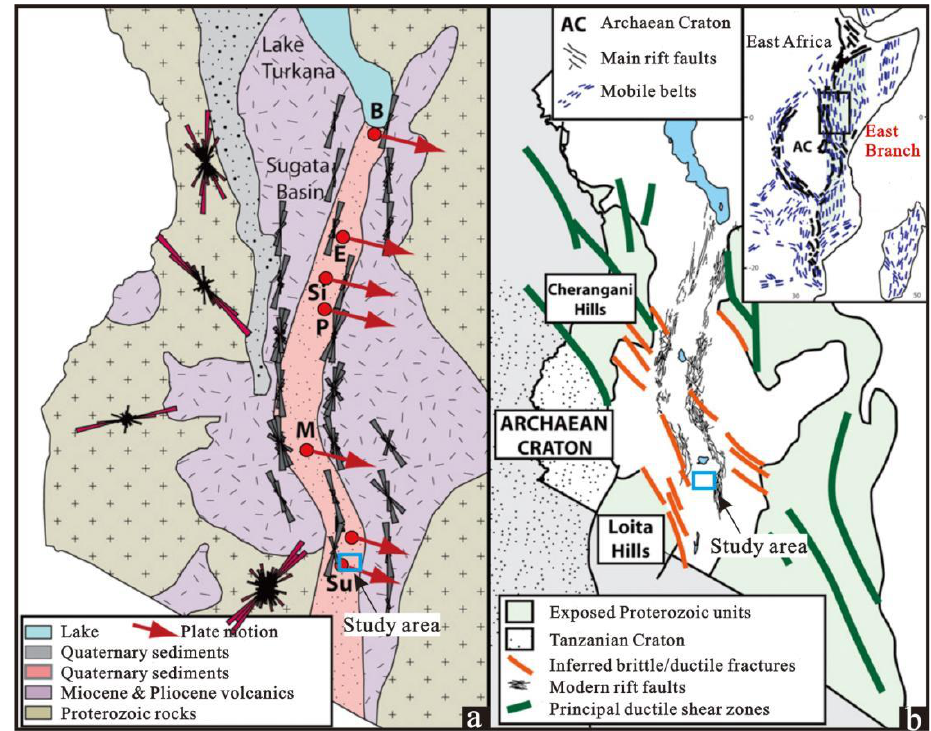
Figure 2. Geological structure of the Kenya Rift Valley, modified from Robertson et al. [13]. ( a ) Sum- mary geological map of the Kenya Rift Valley. ( b ) Exposure of Kenyan Proterozoic units and principal structures. The locations of Quaternary caldera volcanoes (red circles) are labeled as: B, Barrier; E, Emuruangogolak; Si, Silali; P, Paka; M, Menengai; L, Longonot; and Su, Suswa.